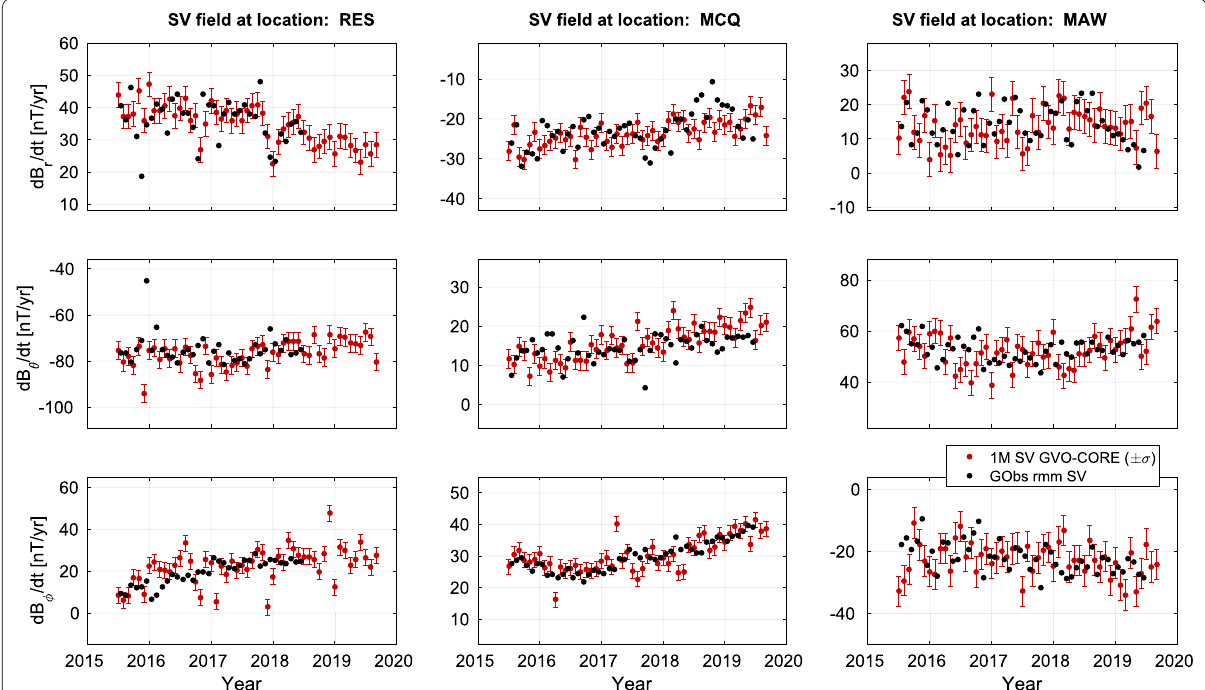
σ uncertainties, and 1-monthly revised monthly means ±